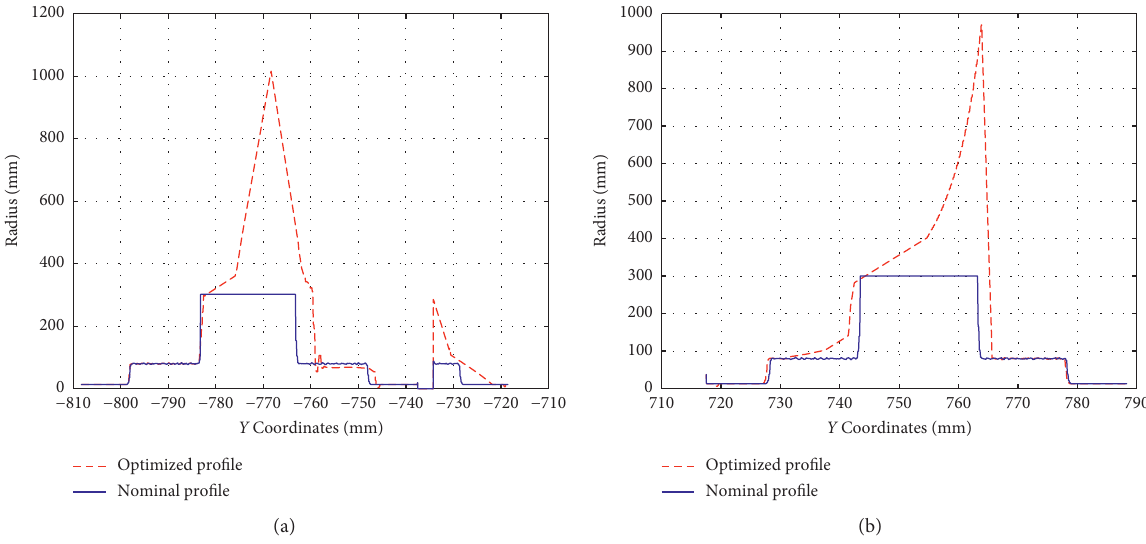
Figure 13: Distribution of radius of the rail profile before and after optimization: (a) switch rail and (b) stock